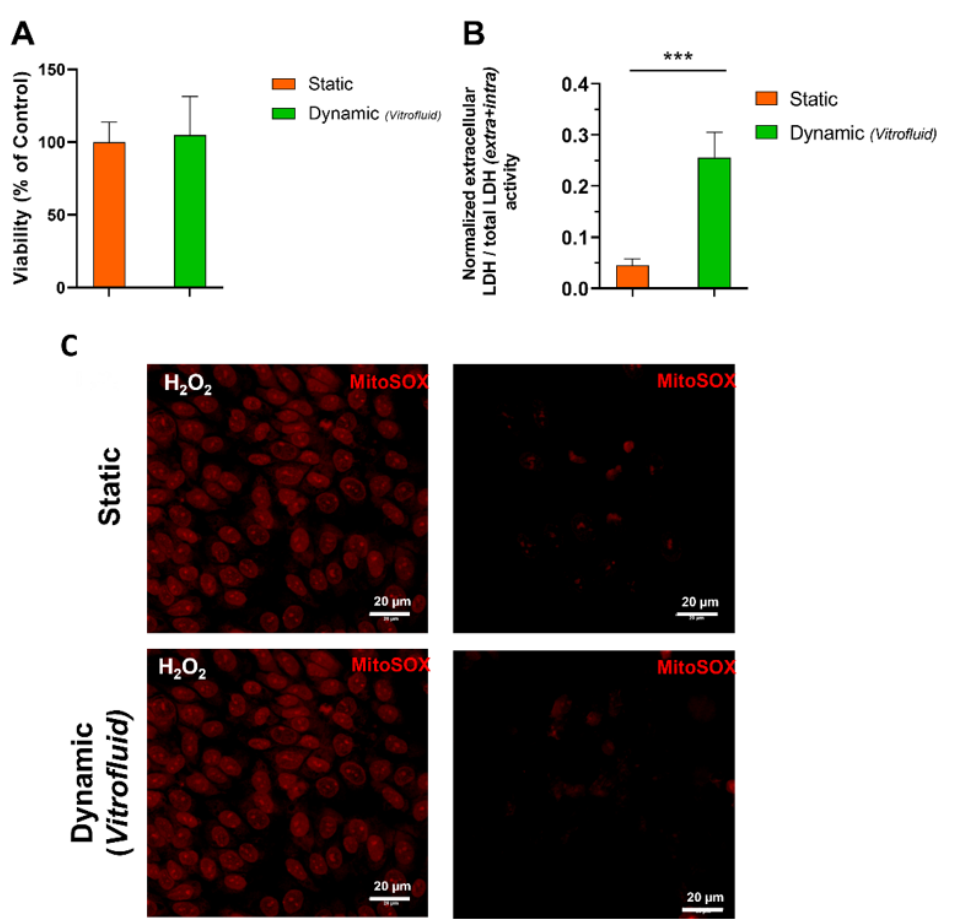
Figure 3. Viability of RPTEC cultures maintained for 7 days under static and dynamic conditions: ( A ) ATP content measured in RPTECs (mean ± SD; n = 3; Student’s t -test). ( B ) LDH concentrations in cell culture media (Mean ± SD; n = 3; Student’s t -test; *** p ≤ 0.001). ( C ) Superoxide detection with fluorescent staining with MitoSox Red ® . Left panels: RPTECs were treated with 1% H 2 O 2 as a positive control, right panels: untreated RPTECs (two biological repeats in technical triplicates).